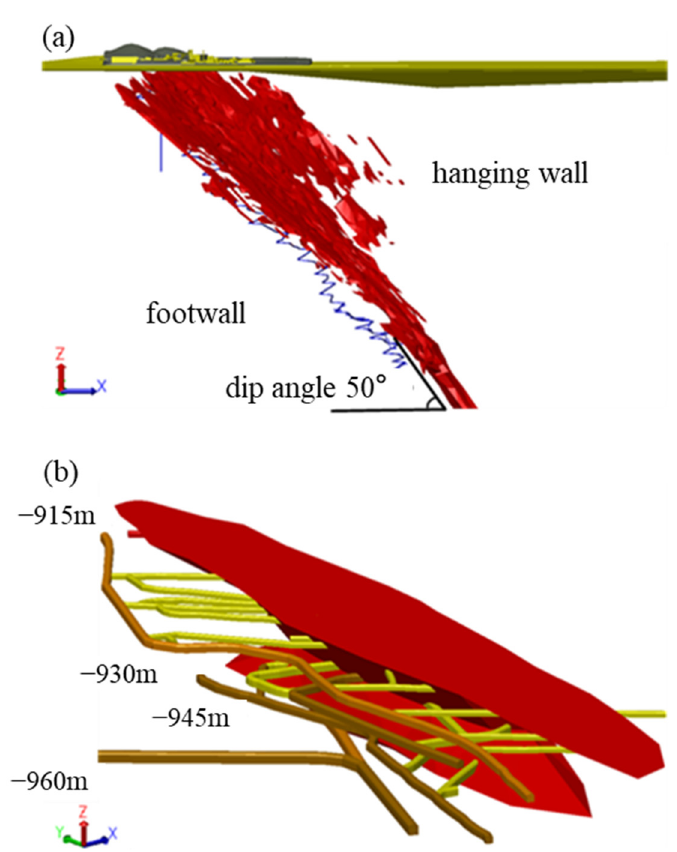
Figure 7. Three-dimensional model of ore body. ( a ) Overall three-dimensional model of ore body; ( b ) Three dimensional model of − 915m ~ − 960m middle section ore body.